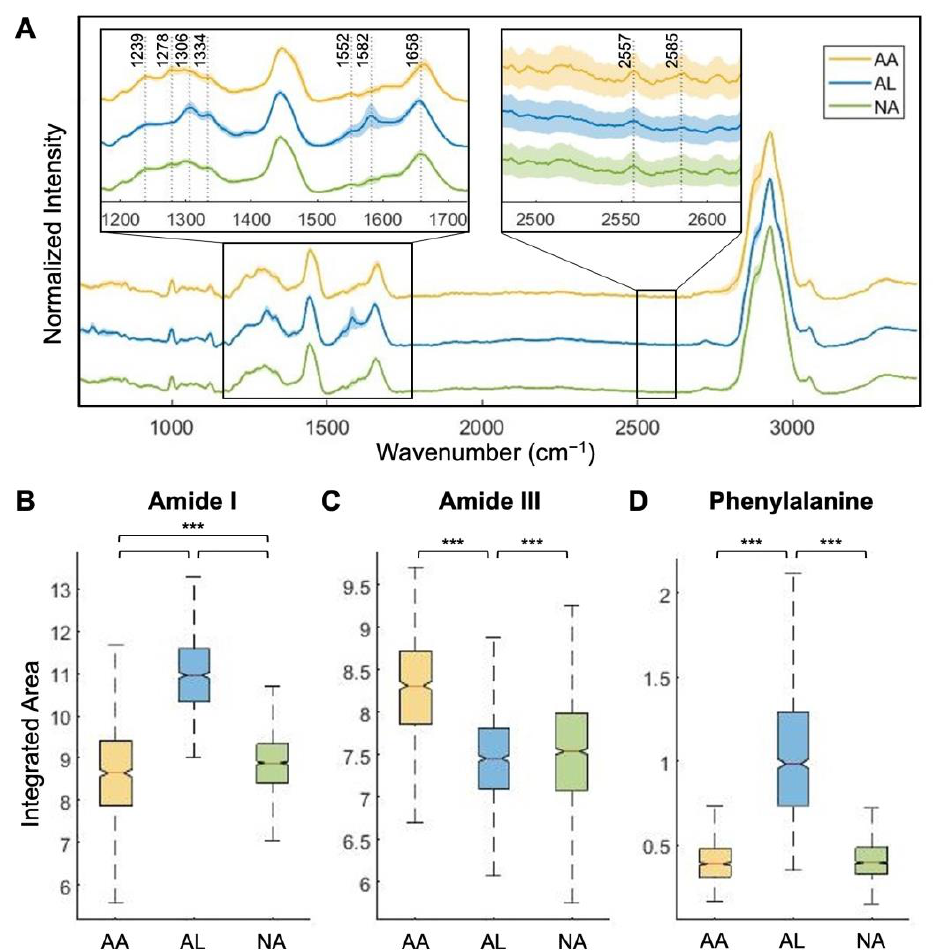
Figure 3. Raman spectroscopy of frozen kidney tissue featuring amyloid deposits. ( A ) Raman spectra of glomeruli within AA, AL, and NA tissues. Each spectrum represents an averaged and normalized spectrum with 1 standard deviation shaded. They are normalized on the spectral region assigned to water (3100 – 3400 cm −1 ), assuming an equivalent water content for all samples. Raman band area analyses of ( B ) amide I (1600 – 1700 cm −1 ), ( C ) amide III (1200 – 1300 cm −1 ), and ( D ) phenylalanine (1582 ± 3 cm −1 ) of AA, AL, and NA glomeruli. Statistical significance: *** p < 0.0001.